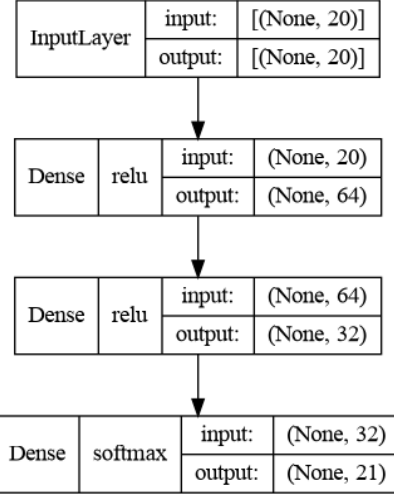
Figure 9. Shallow neural net